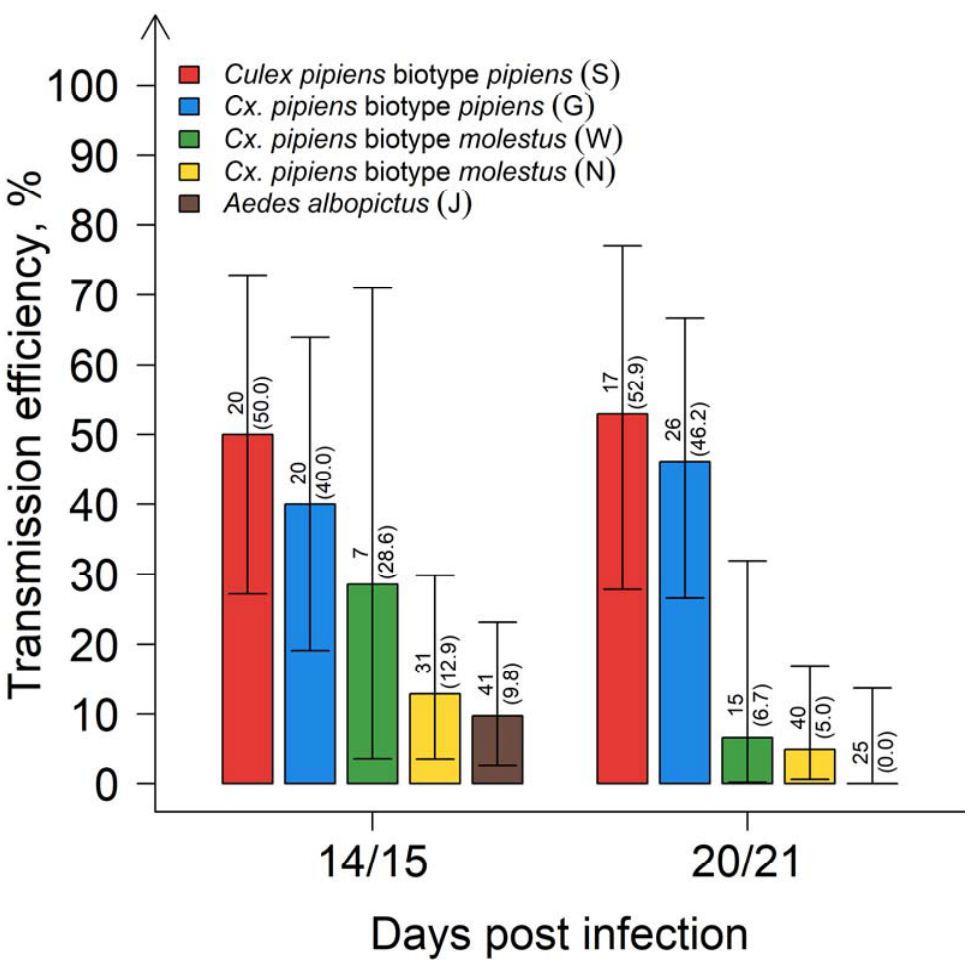
Figure 1. Transmission e ffi ciencies for Cx. pipiens biotype pipiens , Cx. pipiens biotype molestus , and Ae. albopictus 14 / 15 and 20 / 21 days post infection at an incubation temperature of 25 ◦ C. Error bars represent 95% confidence intervals. The number above each bar indicates the number of mosquitoes tested per species / time point, and in brackets, the percentage tested